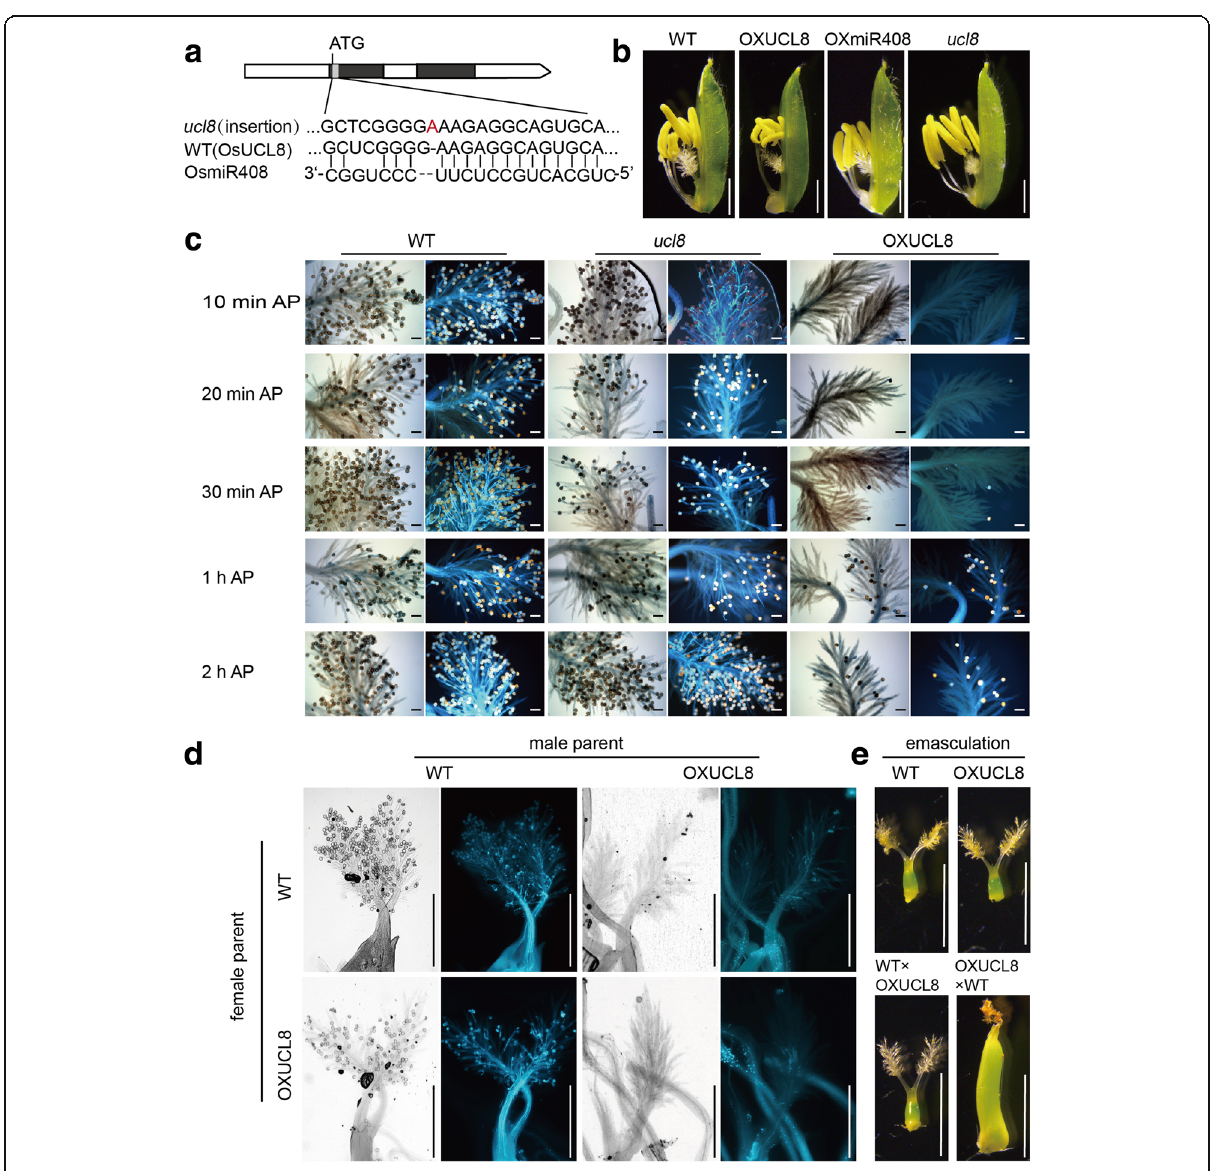
Fig. 1 OsUCL8 affected pollination and pollen germination. ( a ) Genomic structure of rice OsUCL8 and constructions of the transgenic plants. ( b ) Mature spikelet of WT and transgenic plants. Scale bars, 1 mm. ( c ) Aniline blue staining of pollen tube growth in WT and mutants at 10 min, 20 min, 30 min, 1 h, 2 h after pollination (AP). Scale bars, 100 μ m. ( d ) Reciprocal crosses between OXUCL8 and WT 2hs after artificial pollination, Scale bars, 500 μ m. ( e ) Reciprocal crosses between OXUCL8 and WT 3 d after pollination, Scale bars, 3